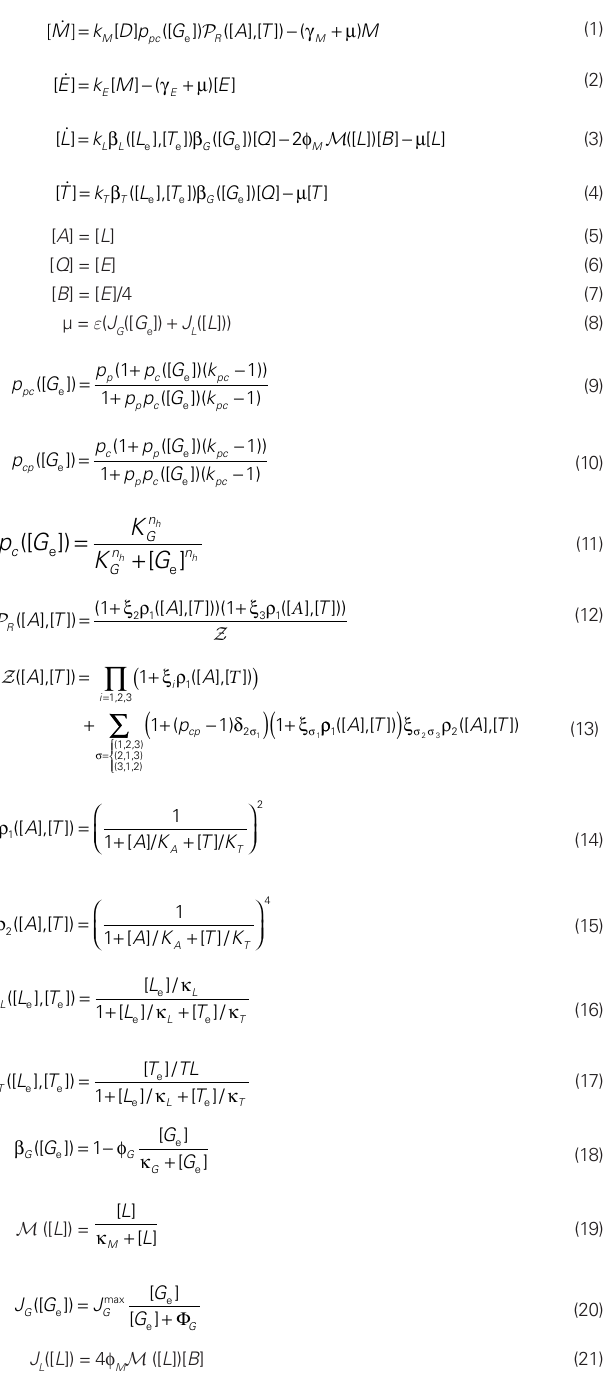
Table 1| Mathematical model for the lac operon regulatory pathway in E. coli, which accounts for the operon simultaneous induction with lactose and